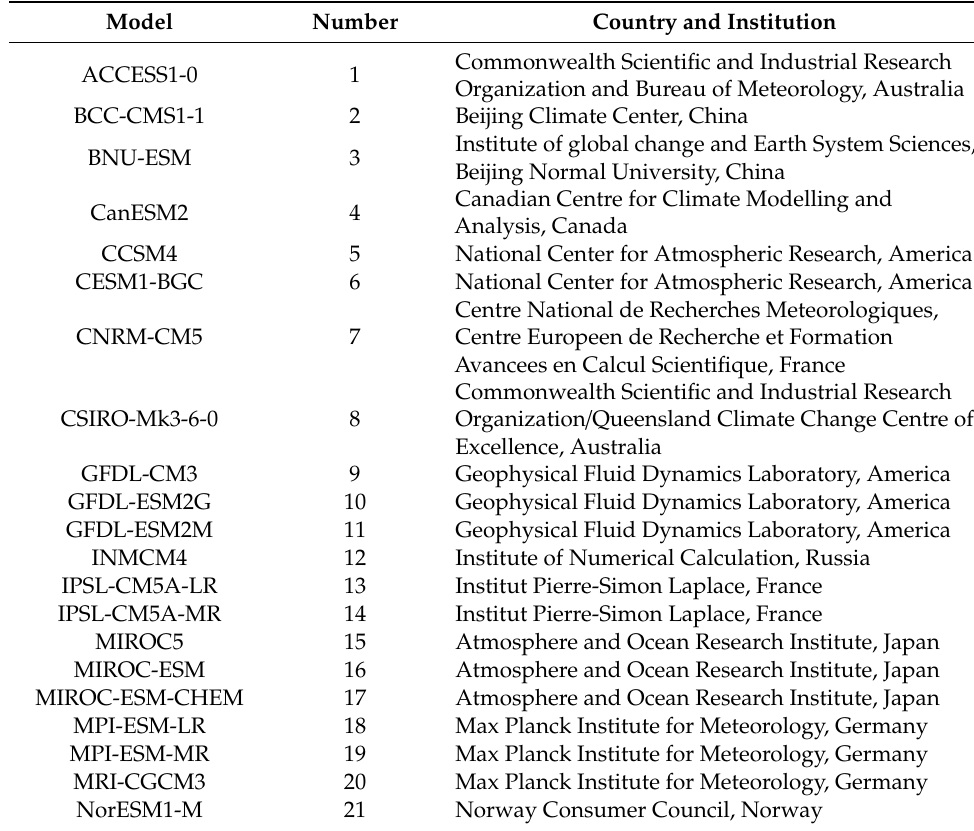
Table 3. Information about the 21 Coupled Model Intercomparison Project 5 (CMIP5) general circulation models